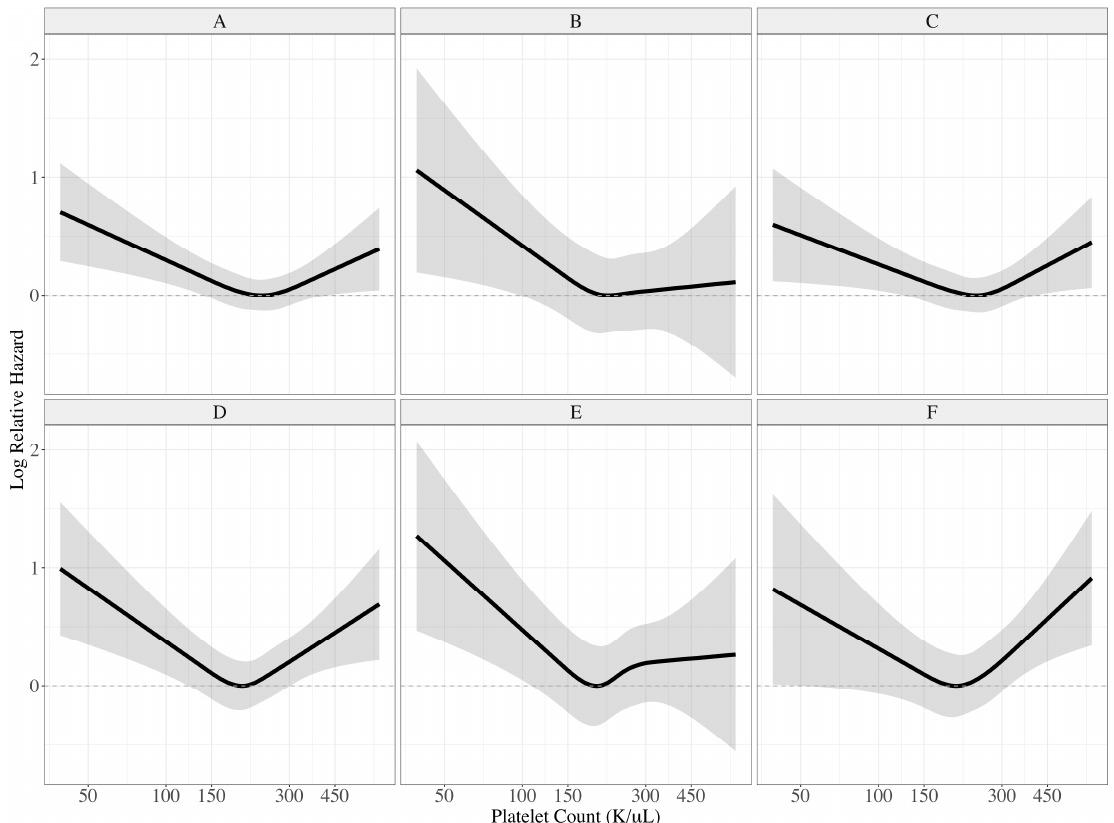
Figure 3. Relative log hazard ratios according to baseline platelet counts for major cardiovascular events (MACE) and Bleeding Academic Research Consortium (BARC) 2, 3, and 5 bleeding. Solid lines represent the calculated log relative hazard, and shaded gray areas represent 95% confidence intervals. ( A ) The 5-year MACE, ( B ) 30-day MACE, ( C ) 30-day to 5-year MACE, ( D ) 5-year BARC 2, 3, and 5 bleeding, ( E ) 30-day BARC 2, 3, and 5 bleeding, ( F ) 30-day to 5-year BARC 2, 3, and 5 bleeding.